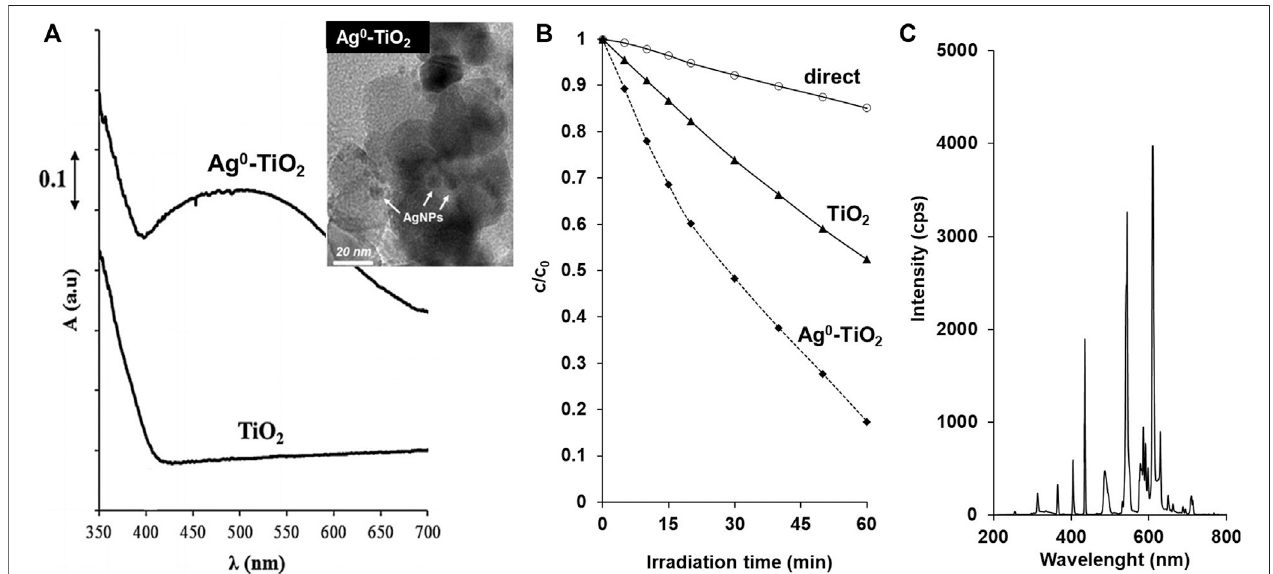
FIGURE 1 | The diffuse re fl ectance spectra of the initial P25 TiO 2 and plasmonic Ag 0 -TiO 2 photocatalyst (0.5 m/m% surface Ag 0 content) with the TEM picture of Ag 0 -TiO 2 photocatalyst (A) ,photocatalyticdegradationofethanolvapouronpurephotocatalyst fi lms (B) aswellasthespectraldistributionofthelightsourceusedinthis experiment (LightTech) (C)